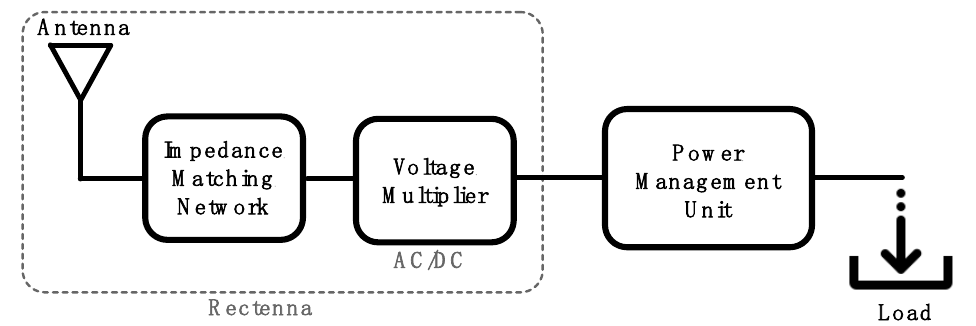
Figure 7. RF harvester block diagram.